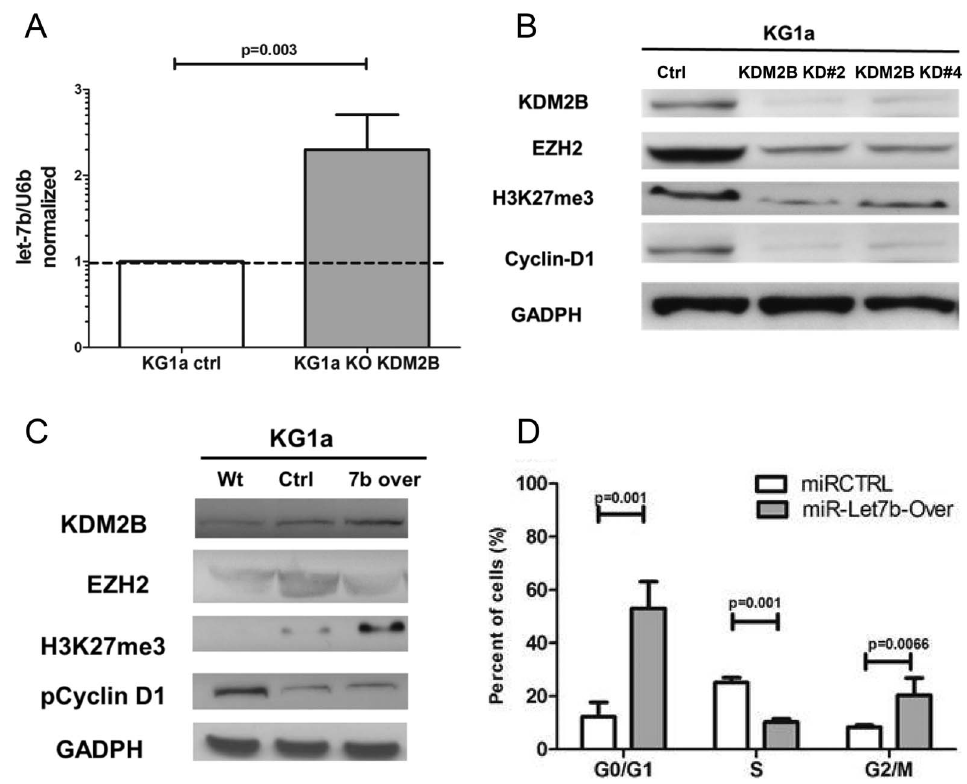
Figure 4. Let-7b overexpression and KDM2B knockdown. A ) Knockdown of KDM2B in KG1a cells was associated with increased expression of let-7b (p=0.003, Results show the mean 6 SEM of 3 experiments; Student’s t-test, U6B served as loading control) B ) Knockdown of KDM2B (constructs # 2 and # 4) in KG1a cells reduced KDM2B, EZH2, H3K27me3 and Cyclin-D1 protein levels. The blots show one of 3 similar experiments. C ) KG1a cells overexpressing let-7b showed increased KDM2B and H3K27m3, and decreased EZH2 protein expression. There was no measurable change of pCyclinD1; GADPH served as control. The blots show one of 3 similar experiments. D ) KG1a cells overexpressing let-7b showed decreased BrdU uptake/proliferation (decrease of cells in S phase; p=0.001, and increase of cells in G1 and G2, p=0.001 and p=0.0066, respectively; results show the mean 6 SEM of 3 experiments; Student’s t-test).